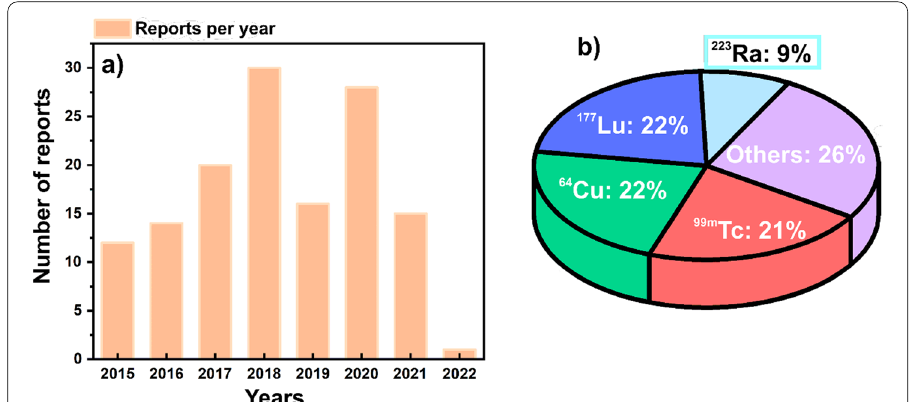
Fig. 1 a Number of publications per year related to radiolabeled nanomaterials for biomedical applications (2015–2022). b Publication percentage of radiolabeled nanomaterials using different